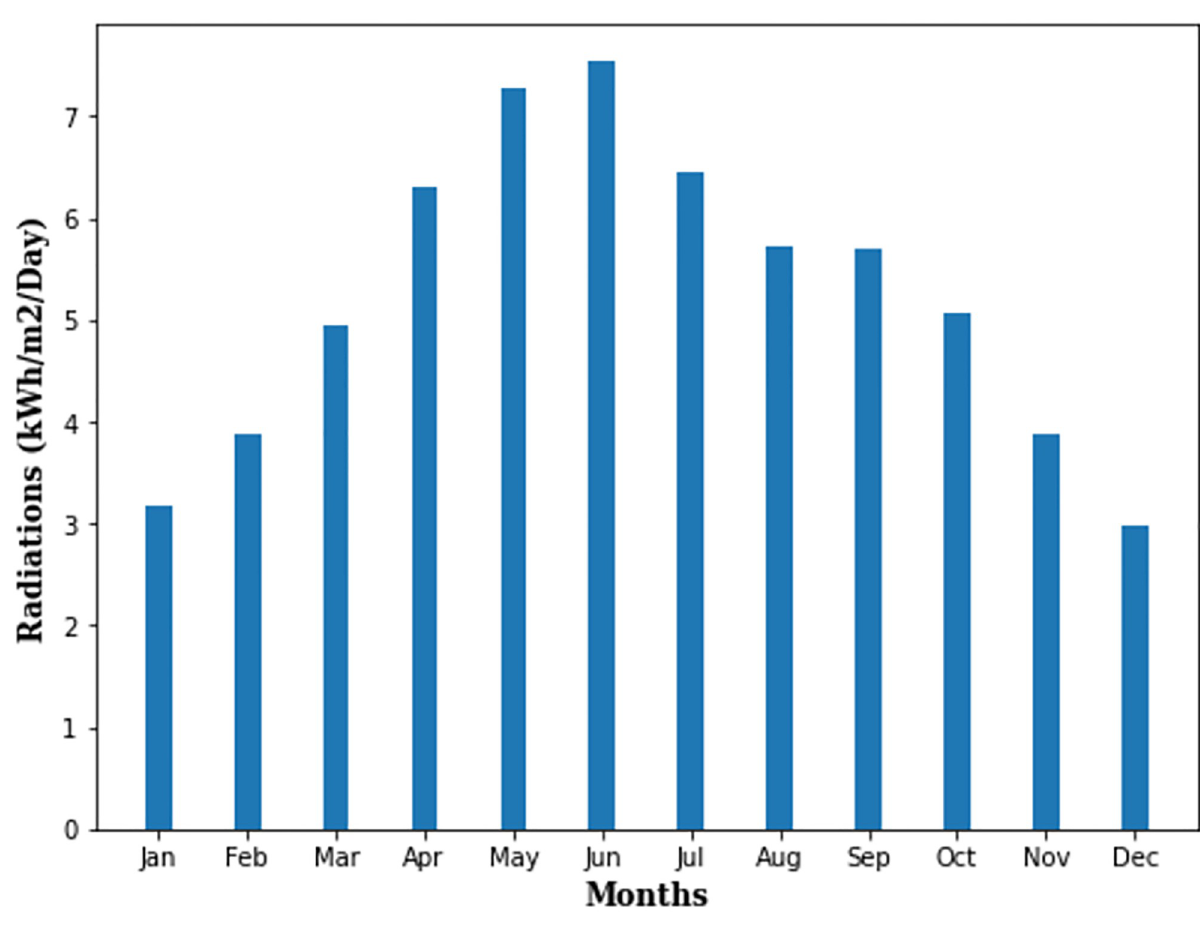
Fig 2. The solar radiations at targeted site.